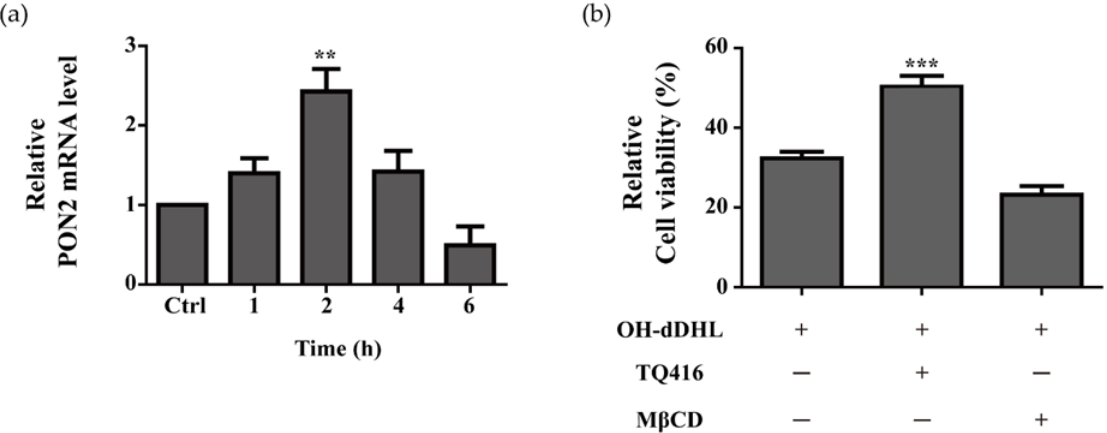
Figure 6. Effect of lipid raft and PON2 on BMDM cells treated with OH-dDHL. ( a ) BMDMs were treated with 50 µM OH-dDHL in a time-dependent manner. Relative expression of mRNA was measured using a real-time quantitative PCR. Gene expression was normalized with GAPDH. ( b ) Cell viability was determined using CCK assays. MβCD (2 µM) was pre-applied for 1 h and TQ416 (4 µM) was applied simultaneously. BMDMs were treated with 50 µM OH-dDHL for 3 h. Data are presented as mean ± SEM of three independent experiments. ***, p < 0.001, **, p < 0.01 vs. OH-dDHL.